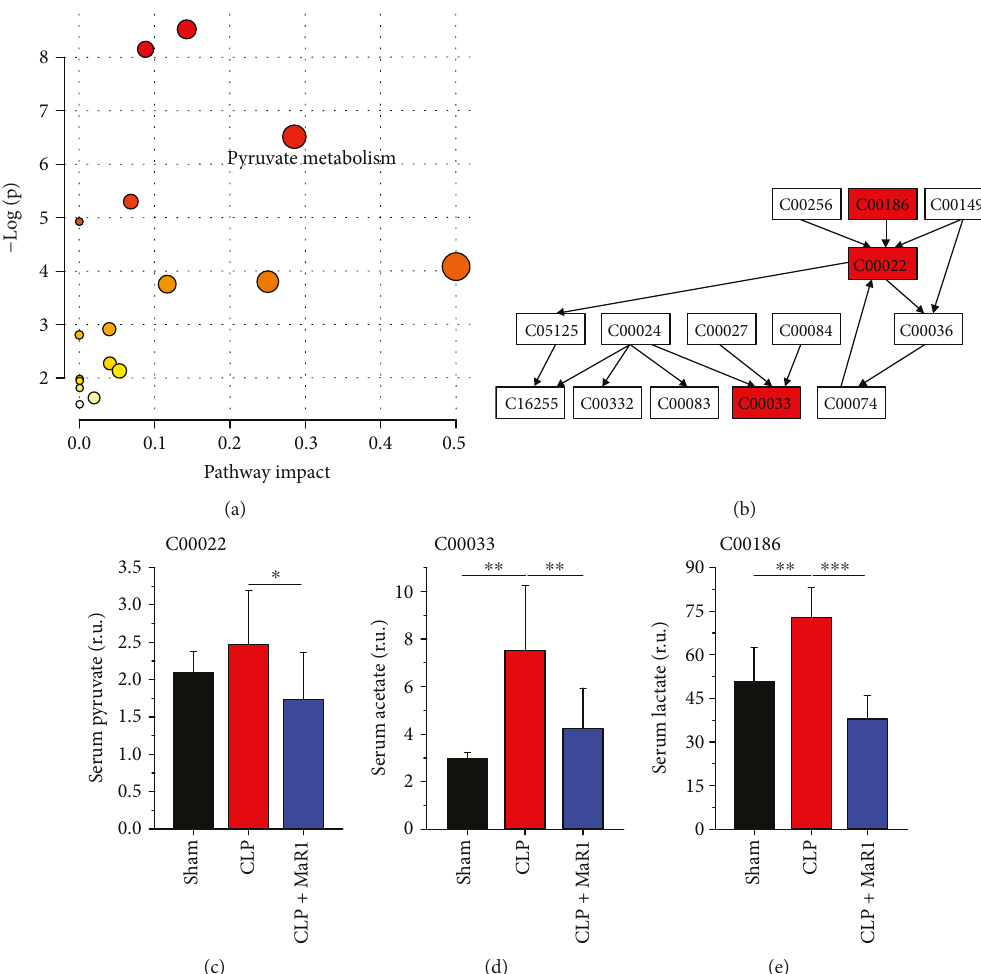
Figure 7: Metabolic pathway analysis in serum of septic mouse treatment with MaR1. Pathway analysis carried out by the pathway topology analysis among three groups (a) and the pathway fl owchart of pyruvate metabolism (b). The key metabolites are shown in (c) ~ (e). ∗ P < 0 05 , ∗∗ P < 0 01 , and ∗∗∗ P < 0 001 , n = 6 per